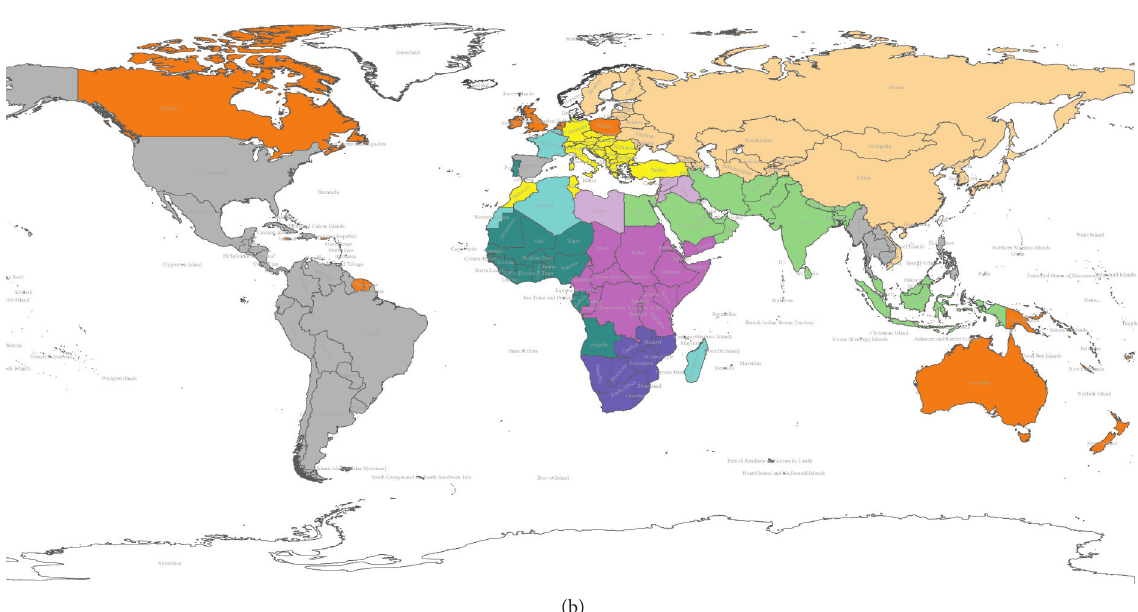
Figure 11: Community map of GMNs in the 1960s and the 2010s showing the characteristics related to geographical